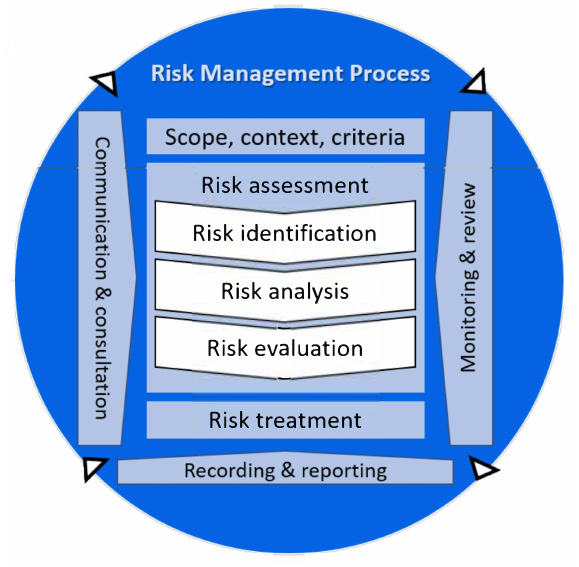
Figure 1. General aspects of risk management from ISO 31000. The risk management process involves the systematic application of policies, procedures and practices to the activities of communicating and consulting, establishing the context and assessing, treating, monitoring, reviewing, recording and reporting